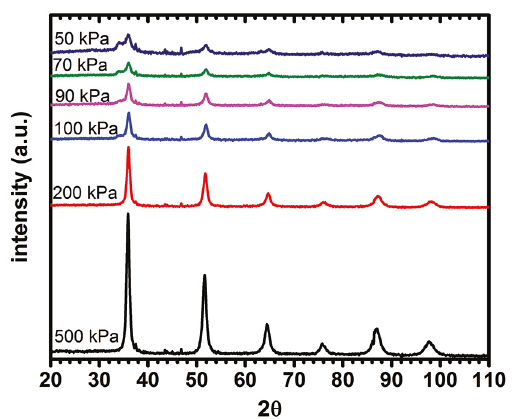
Figure 4: In situ desorption neutron diffraction of the deuterated single-melt 52Ti-12V-36Cr+4%wt. Zr patterns were recorded at